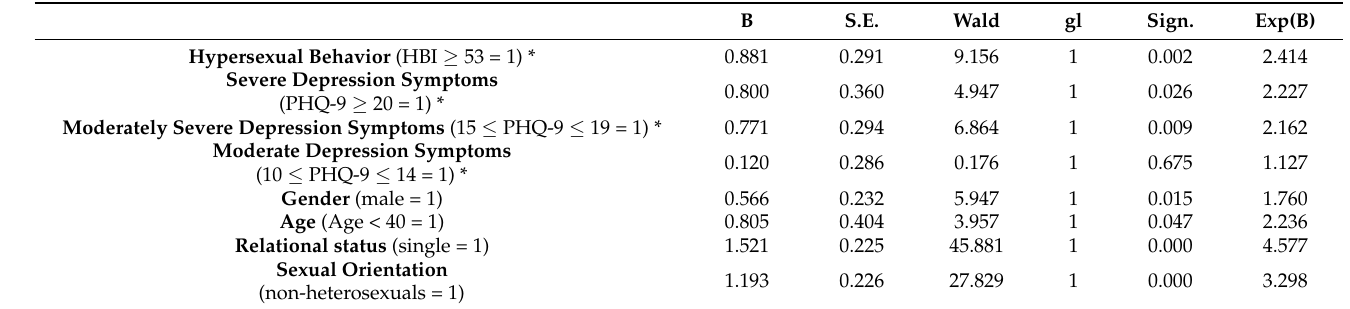
Table 4. Binary logistic regression about hypersexual behavior, depression symptoms, and sociode- mographic aspects in DA